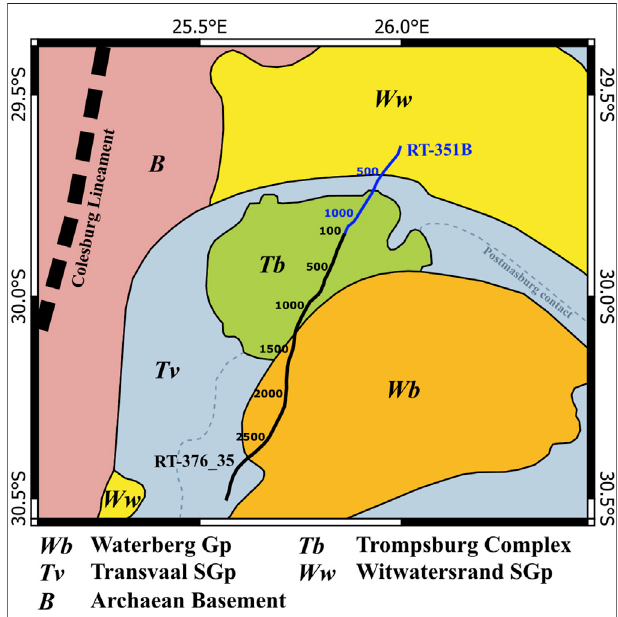
FIGURE 2 | Sub-Karoo Supergroup map of the study area with seismic pro fi les P1 (RT-376) and P2 (RT-351) overlaid. Modi fi ed after McCarthy et al. (2018). Gp, Group. SGp,